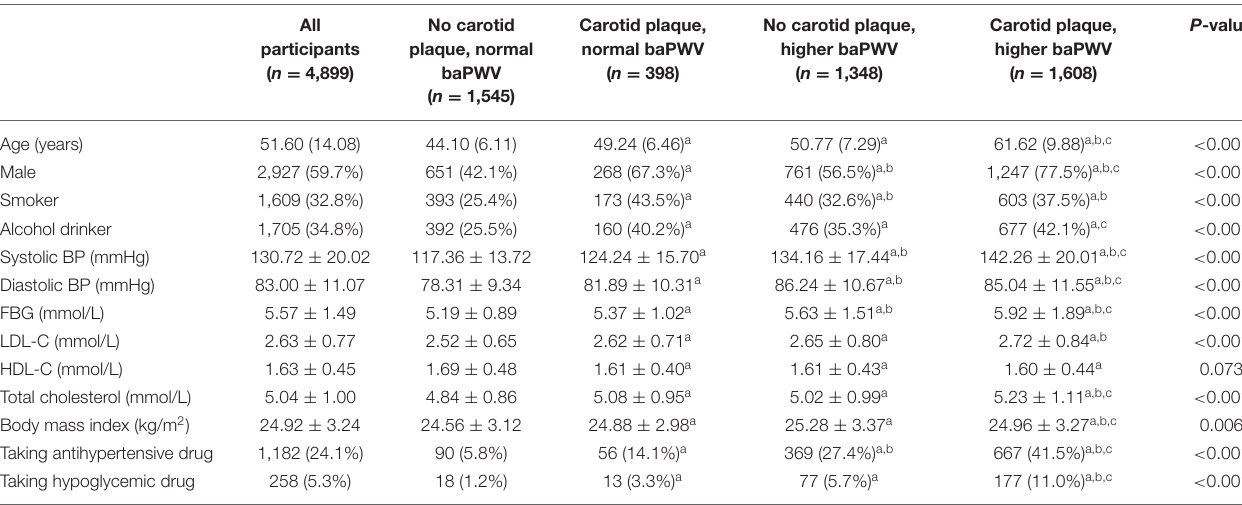
TABLE 1 | Baseline characteristics of the study population.